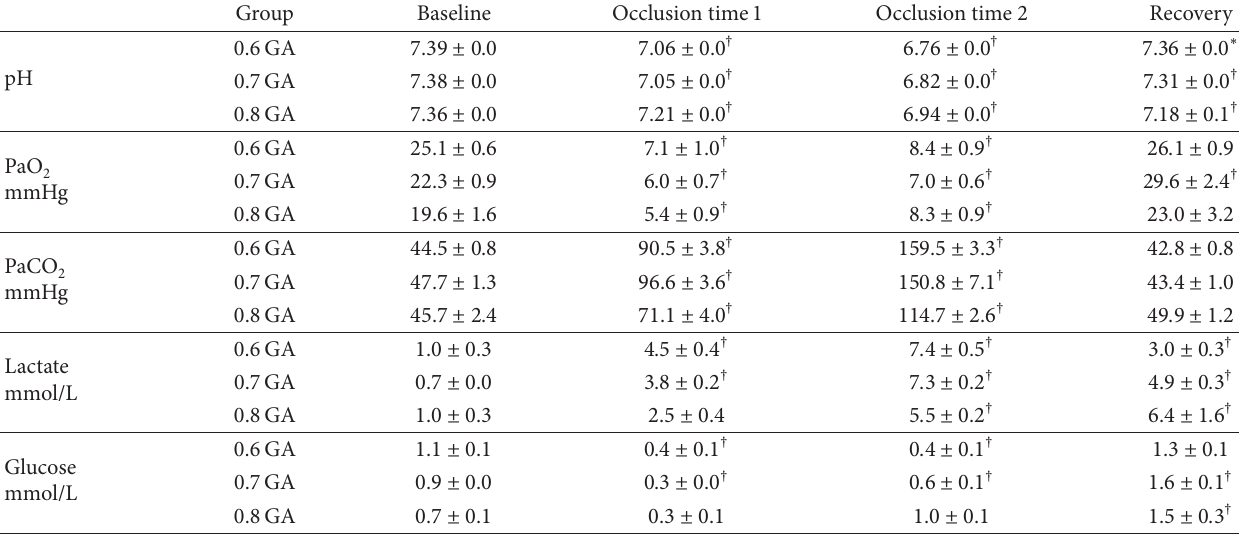
Table 2: Blood composition